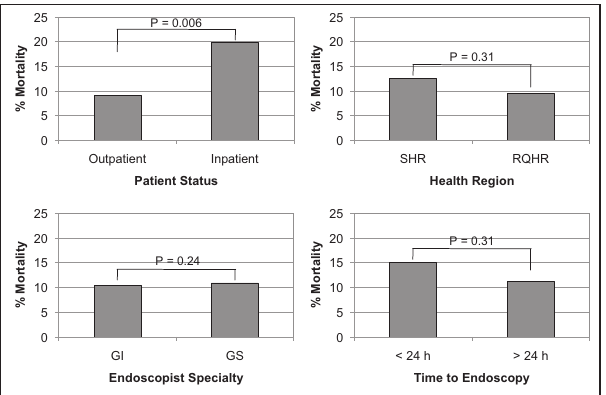
Figure 1) Mortality in patients presenting with nonvariceal upper gastro- intestinal bleeding in the Saskatoon Health Region (SHR) and Regina Qu’Appelle health regions (RQHR) stratified according to patient status, health region, endoscopist specialty and time to endoscopy. The level of sta- tistical significance is indicated by the given P value. GI